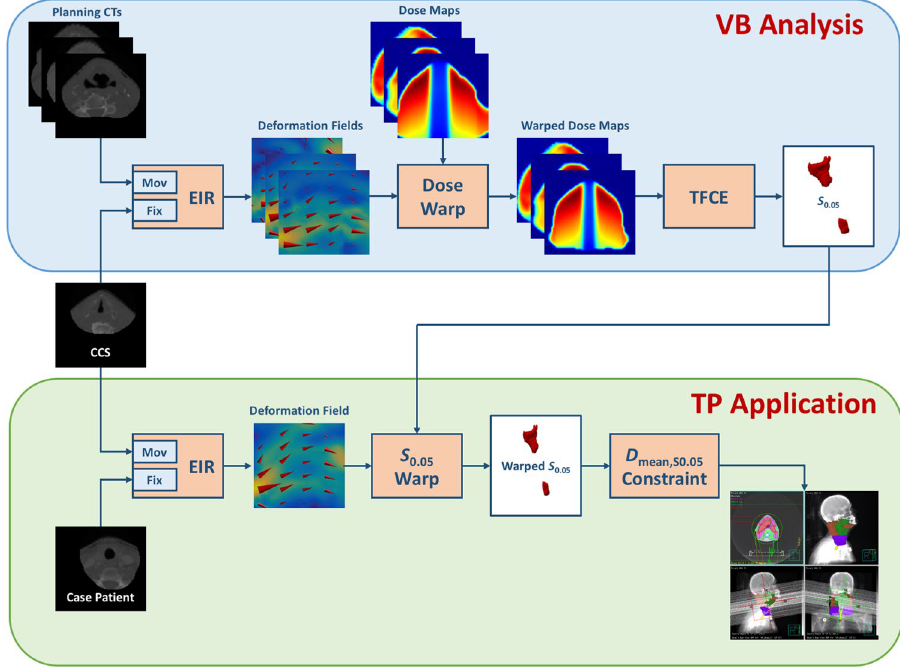
Figure 1. Schematic flowchart of the voxel-based (VB) analysis (upper panel) and of its treatment planning (TP) application (lower panel) in head and neck (HN) cancer patients. Planning CTs are registered to the common coordinate system (CCS) by an elastic image registration (EIR) tool. The obtained deformation fields are used to warp the dose maps into the CCS. A statistical mapping scheme (TFCE) is applied to extract the clusters of voxels ( S 0.05 ) significantly associated with higher doses released in patients developing the radiation- induced toxicity. For any new HN patient (case patient), the S 0.05 region is warped as a new avoidance structure into the DICOM-RT object according to the deformation field that maps the CCS into the considered planning CT, and the corresponding mean dose (D mean, S 0.05 ) is used as planning